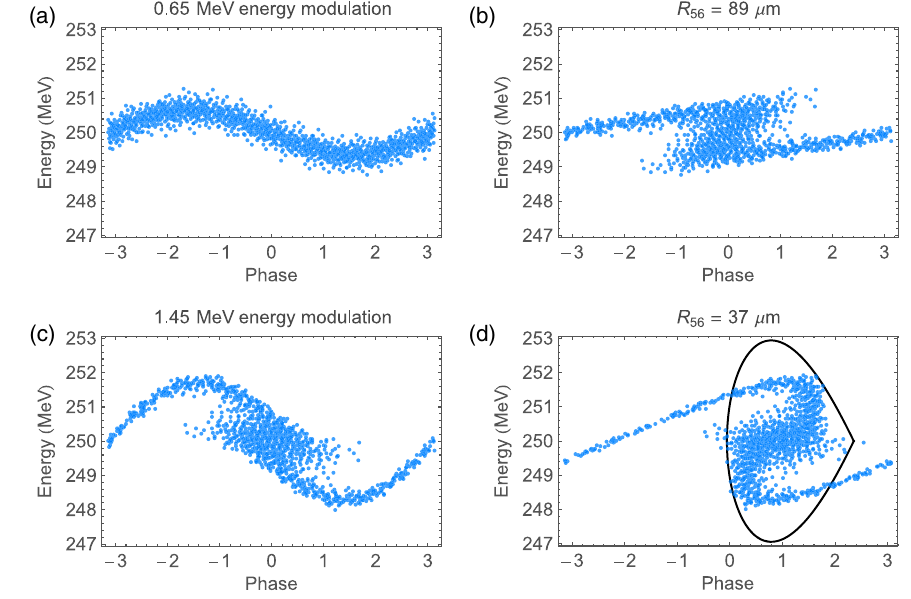
FIG. 4. Prebunching via cascaded energy modulator and chicane